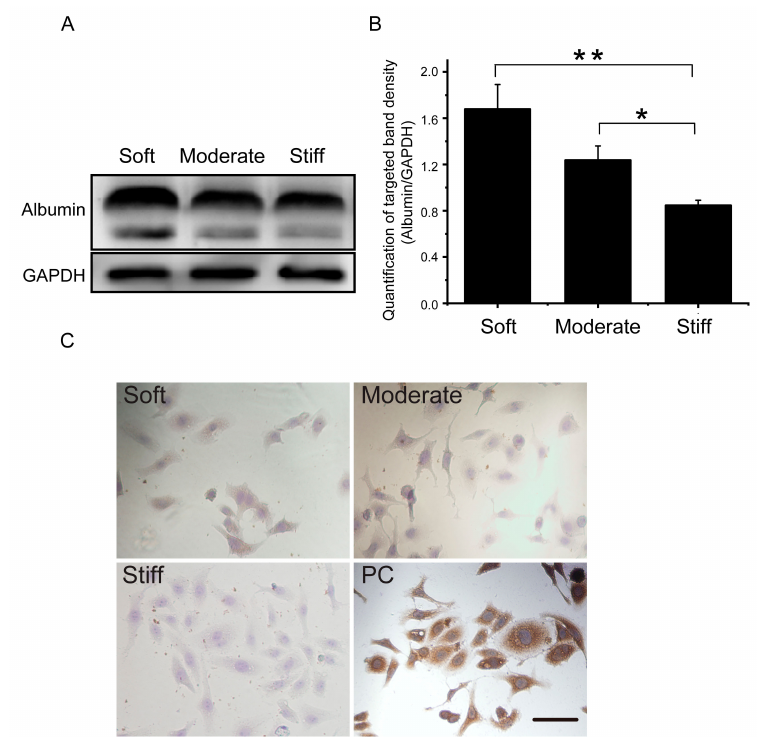
Figure 6. Substrate sti ff ness a ff ects albumin expression in hepatocytes cultured on soft, moderate, and sti ff substrates for 48 h. ( A ) Protein synthesis of albumin was detected by Western blot. ( B ) Band density was analyzed by Quantity One software. ( C ) Protein synthesis of albumin was detected by immunocytochemistry. Cells cultured on a plastic culture dish were used as a positive control; scale bar = 25 µ m. Soft and moderate groups compared to the sti ff group. Data were presented as the mean ± SEM ( n = 3). * represents p < 0.05; ** represents p <